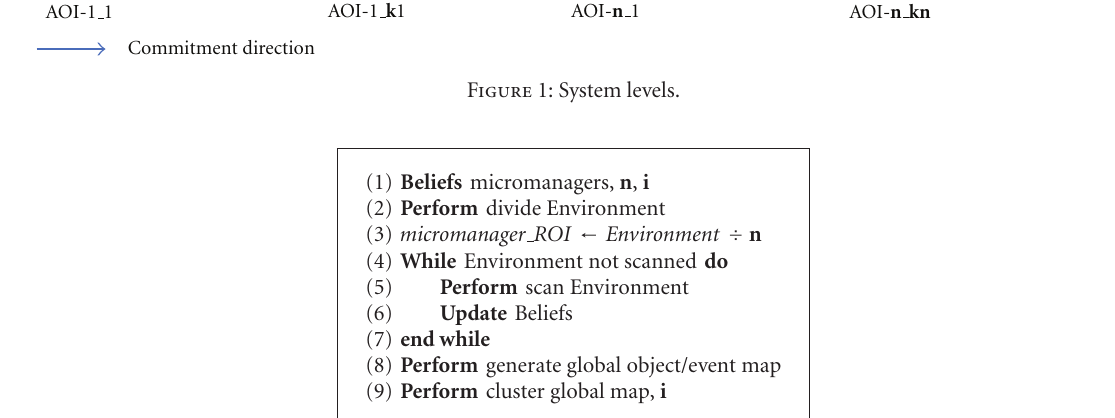
Figure 1: System levels.